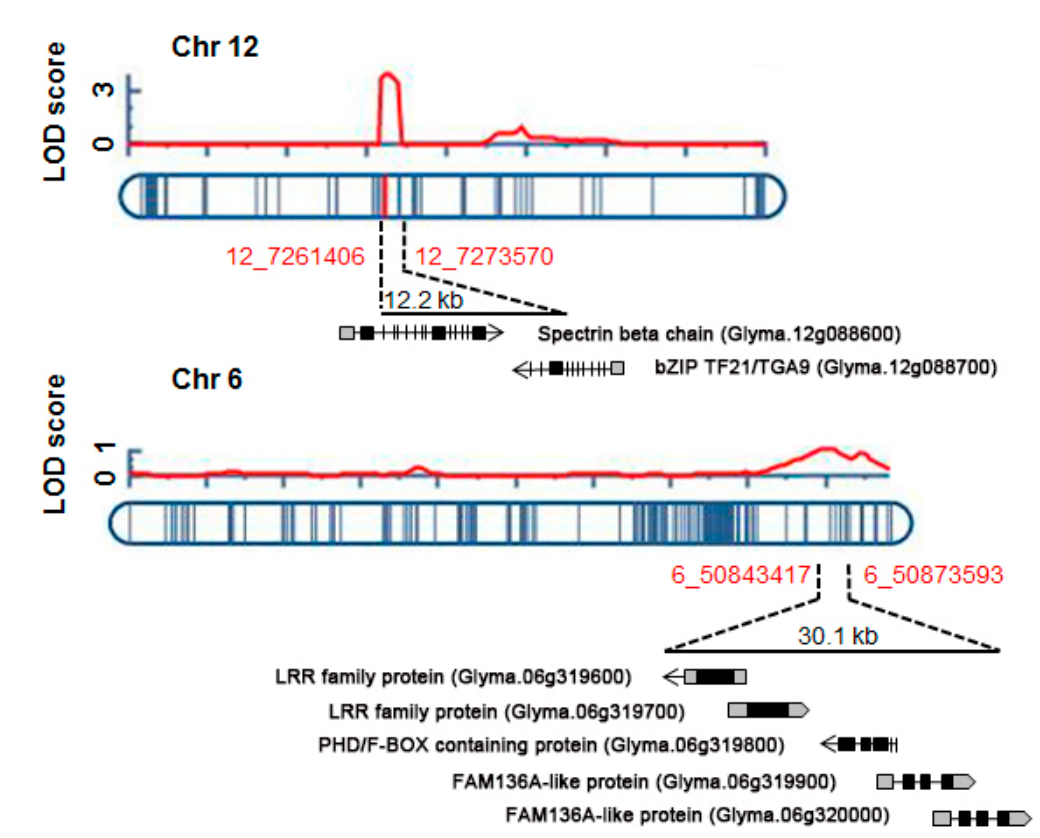
Figure 2. LOD peaks and chromosomal locations of two QTLs UVBR12-1 and UVBR6-1 for resistance to high-intensity UV-B irradiation on chromosome (Chr) 12 and Chr 6. Red curves present LOD score distribution of detected QTLs on Chr 12 and Chr 6. These loci contain two and five protein-coding genes, respectively.